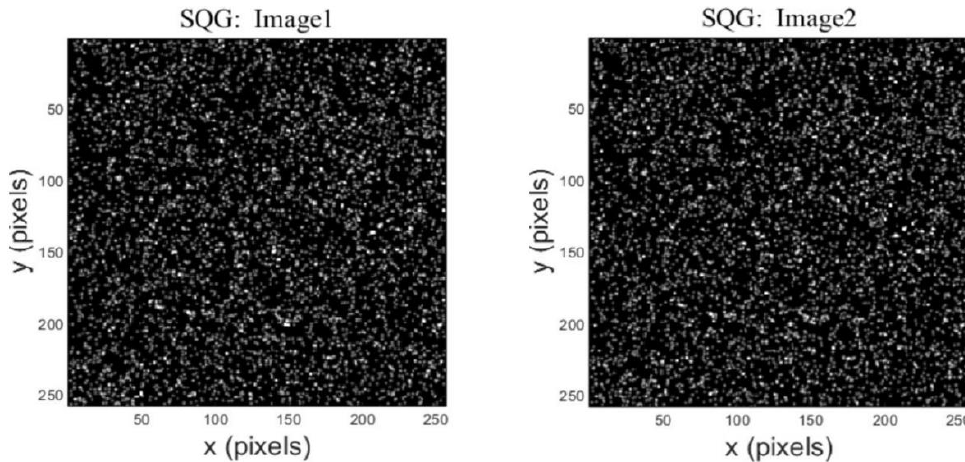
Figure 11. An image pair from SQG flow.